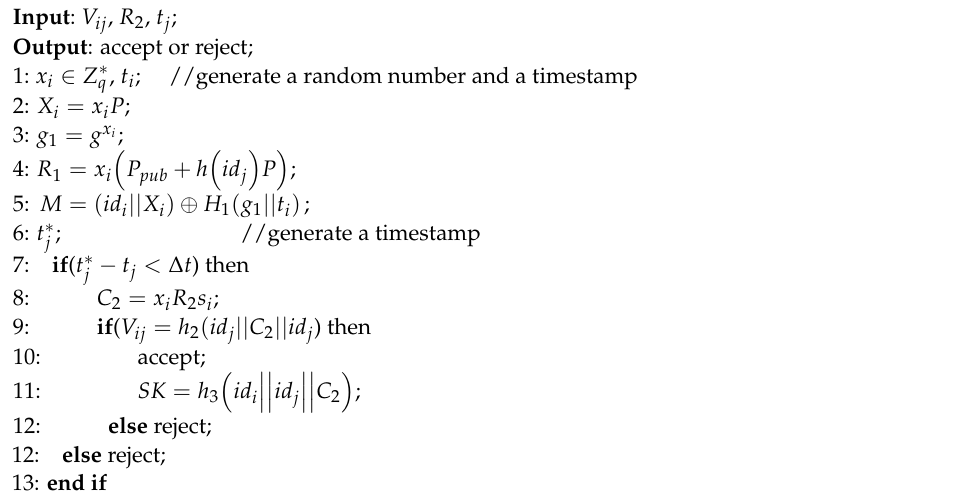
Algorithm 3. SM i authenticates AG